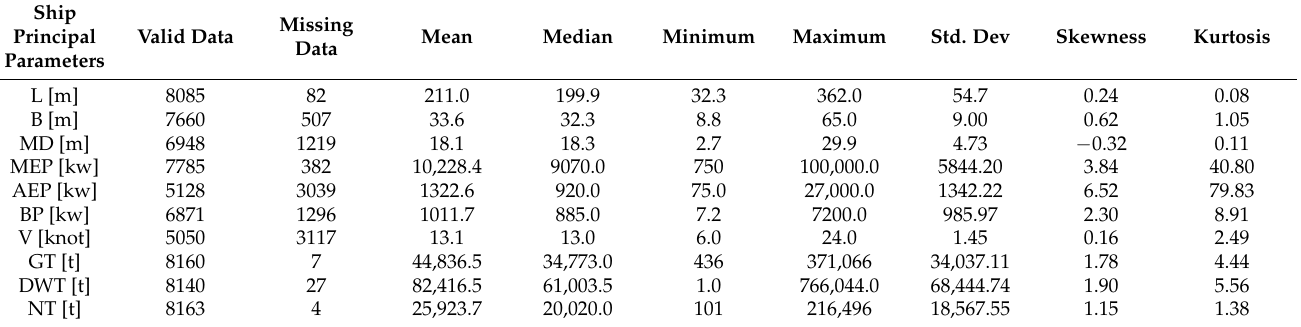
Table 2. Descriptive statistics of the main design parameters of 8167 bulk carriers in ship static data.